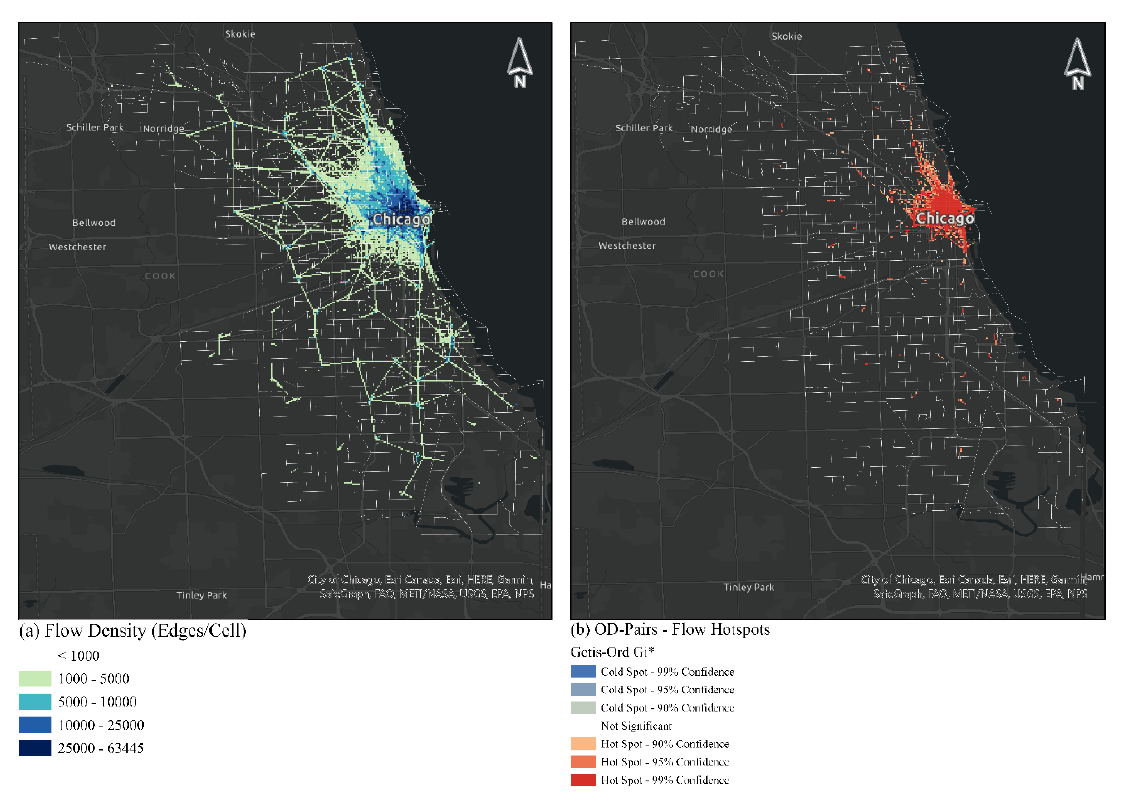
Figure 9 : Chicago TNC Trips OD Map (Pairs’ Flow > 2000 trips): (a) Flow Density – Edges/Cell; (b) OD-Pairs- Flow Hot